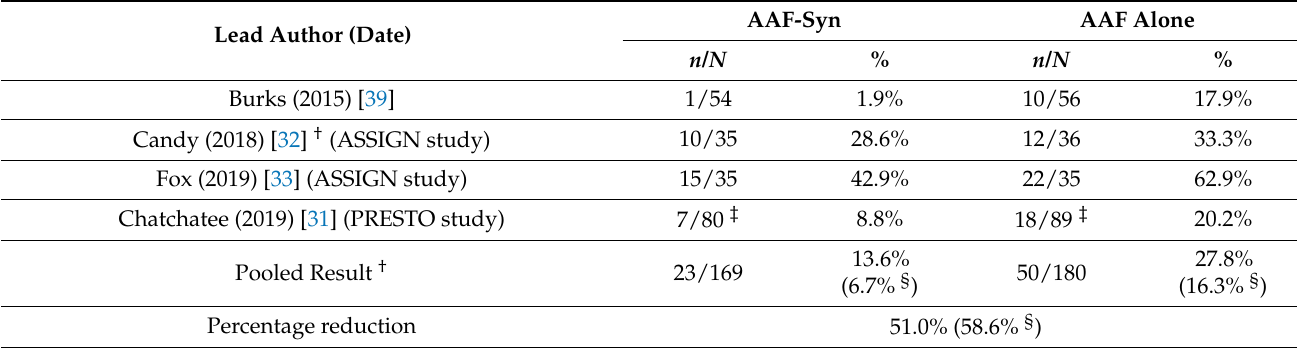
Table 3. Individual and pooled analysis of the percentage of infants who experienced infections, when receiving AAF-Syn vs.